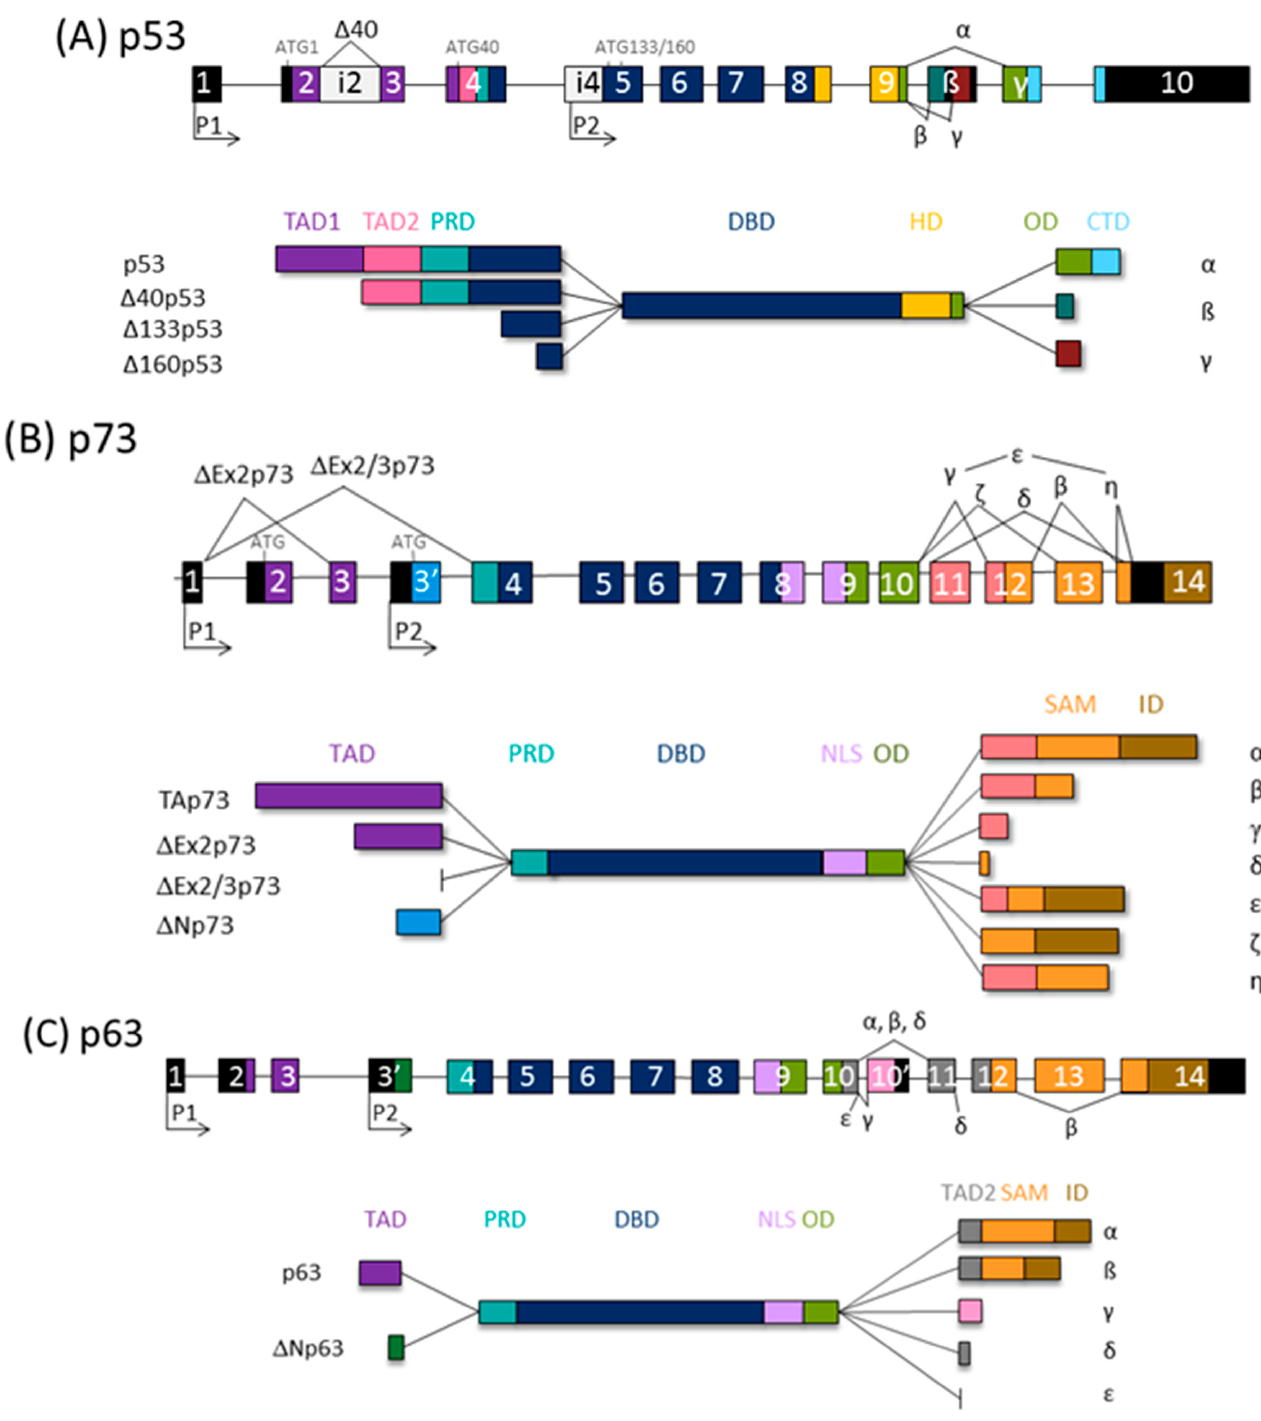
Figure 1. The p53 family gene architecture and generation of the protein isoforms. The scheme of the ( A ) human TP53, ( B ) TP73, and ( C ) TP63 gene (upper) and protein (lower panels). TAD, transactivation domain; PRD, proline-rich domain; DBD, DNA binding domain; ID, inhibitory domain; HD, hinge domain; NLS, nuclear localization signal: OD, oligomerization domain; CTD, C-terminal domain; SAM, sterile alpha motif; ID, inhibitory domain (model adapted from [39]).